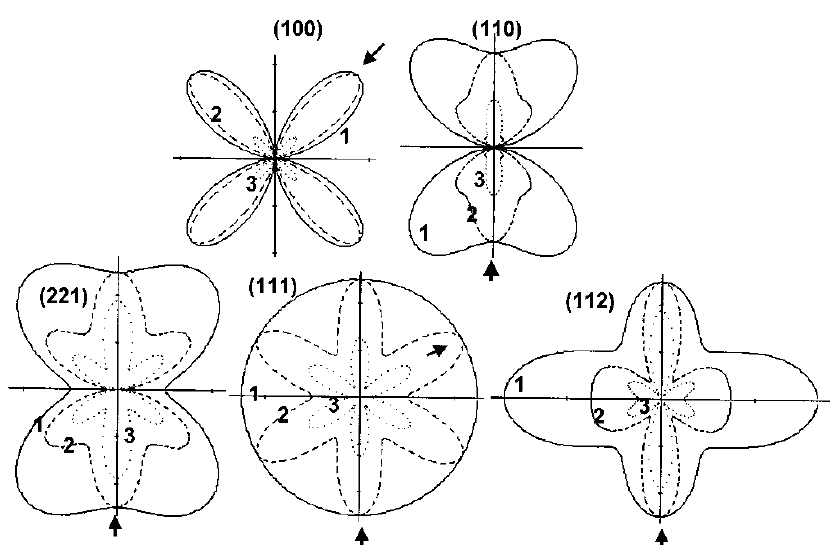
FIGURE 3 Polar plots (in arbitrary units) of functions K 1 (full lines), K 2 (broken lines) and K 3 (dotted lines) in various cross-sectional planes as indicated in figures. The factor of amplification for functions K 2 and K 3 with respect to function K 1 is equal to 4 expected for the (111) cross-section. Arrows indicate h 110